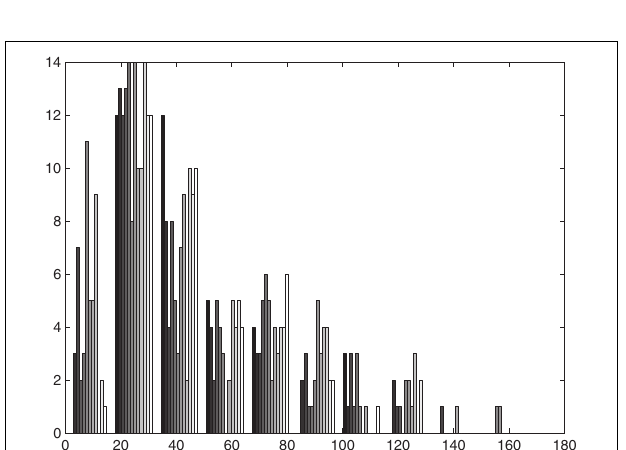
FIGURE 6 | Above: Optimal 8 point design for Gaussian kriging. Below: Optimal 14 point design for Gaussian kriging. Certain locations have been selected with multiplicities larger than 1. Red dots: Sampling locations added.